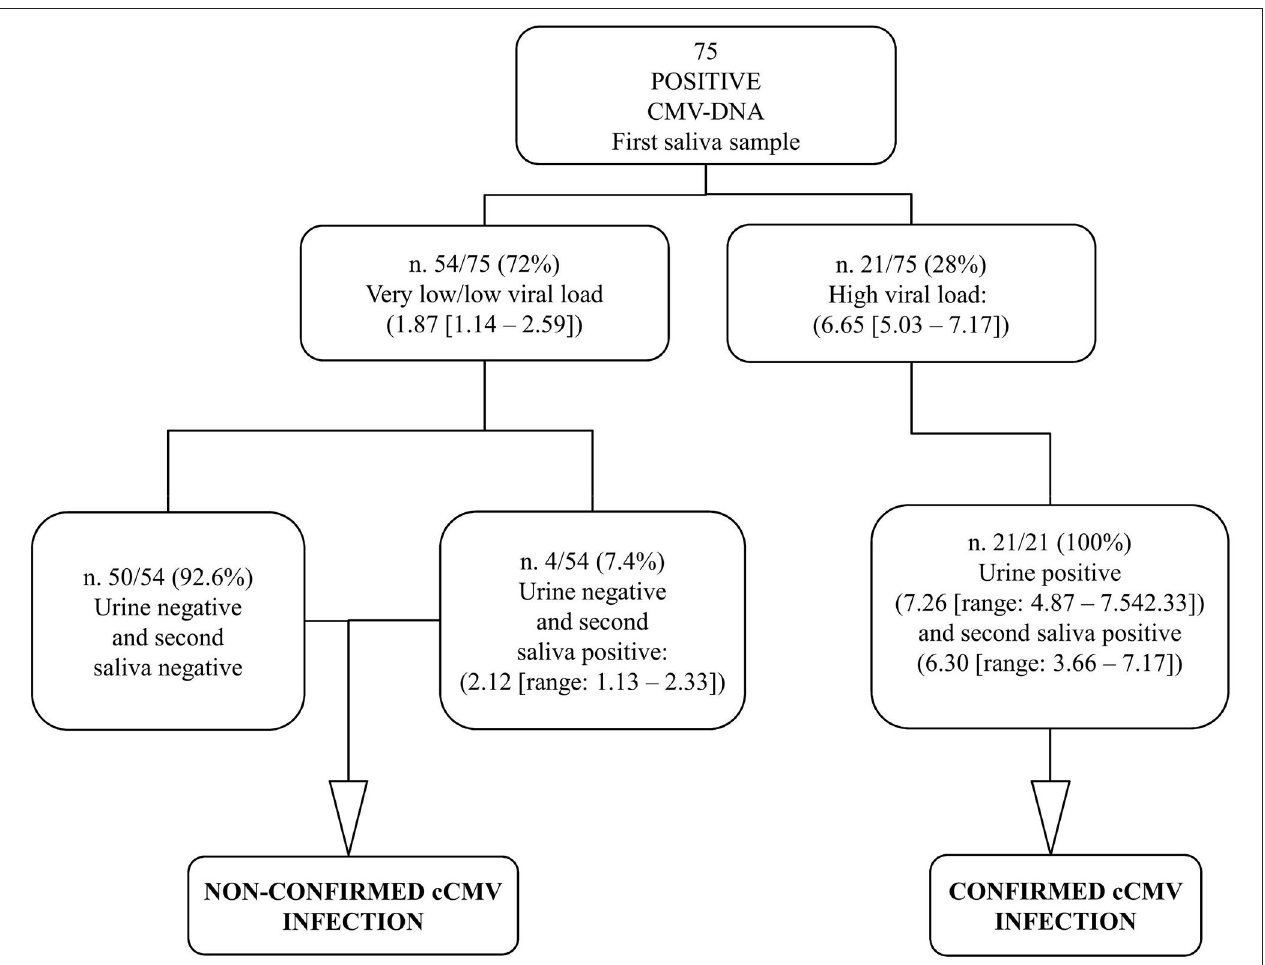
FIGURE 3 | Graphical representation of the results obtained by confirmatory testing. CMV-DNA loads were expressed as log 10 IU/ml (median value,